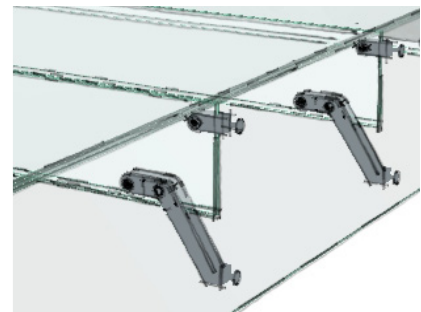
Figure 3: Cross beam to floor panel connection. Figure 4: Cross beam to balustrade